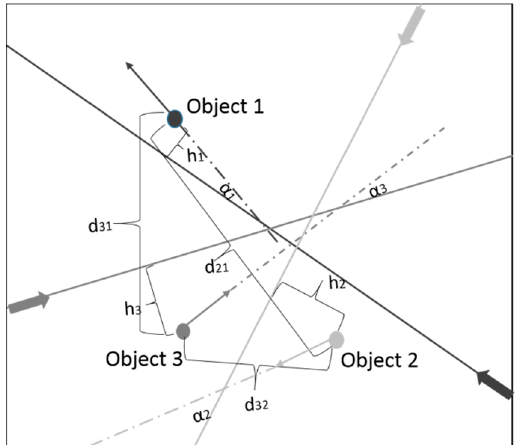
Figure 3. Feature